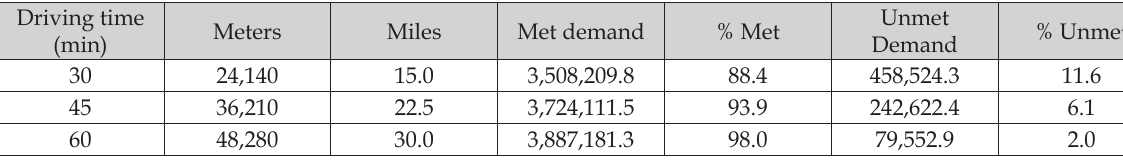
Table 4. Weighted aggregated block model results